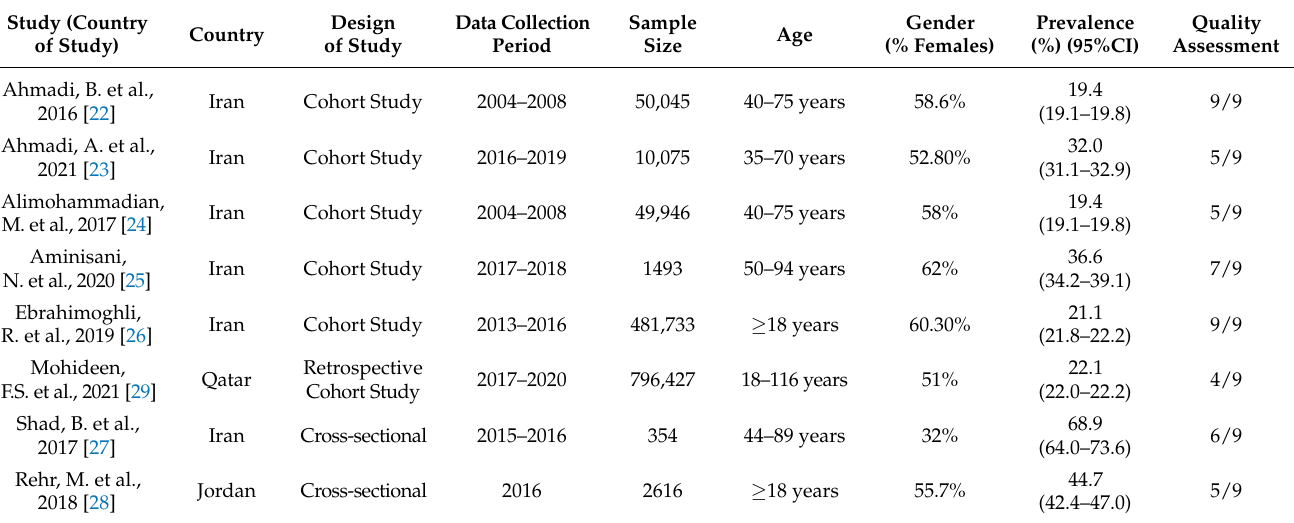
Table 1. Characteristics of included